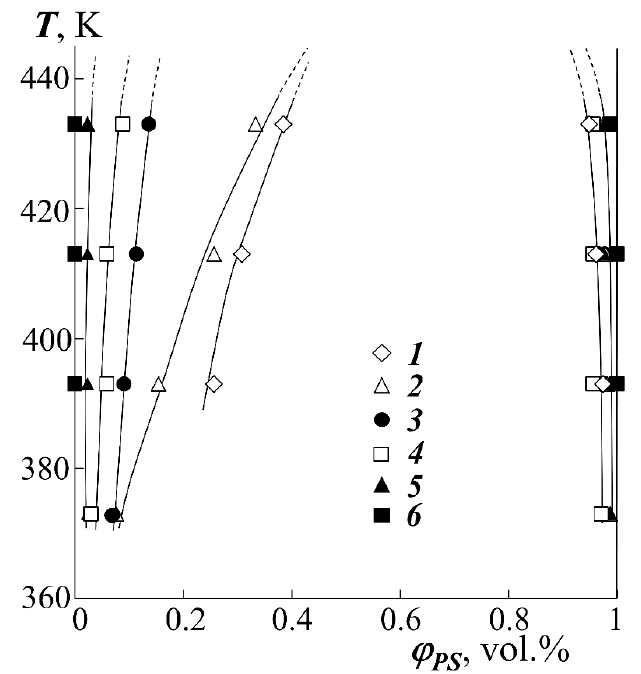
Figure 5. Fragments of binodal curves for the systems PEHA–PS-1 (1), PEA–PS-1 (2), PBA–PS-2 (3), PMA–PS-1 (4), PEA–PS-2 (5) and PMA–PS-2